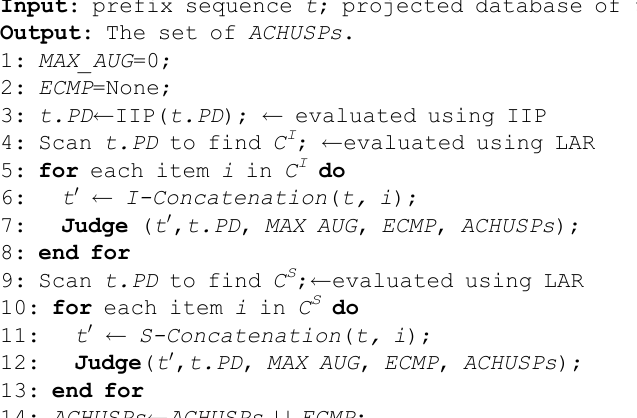
Algorithm 2 Project-Mining( ( t , t.PD , ACHUSPs